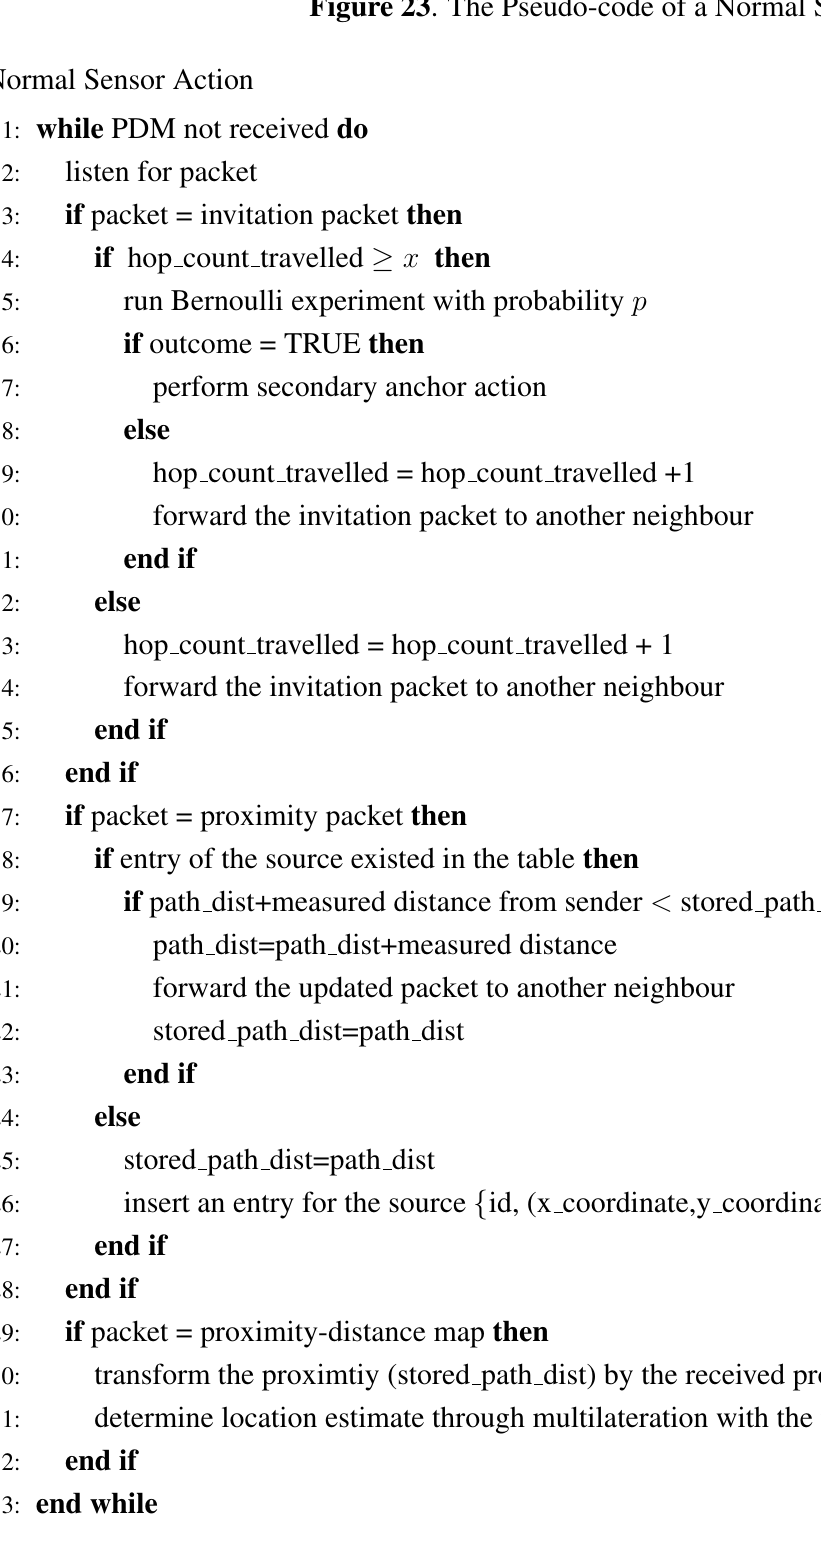
Figure 23 . The Pseudo-code of a Normal